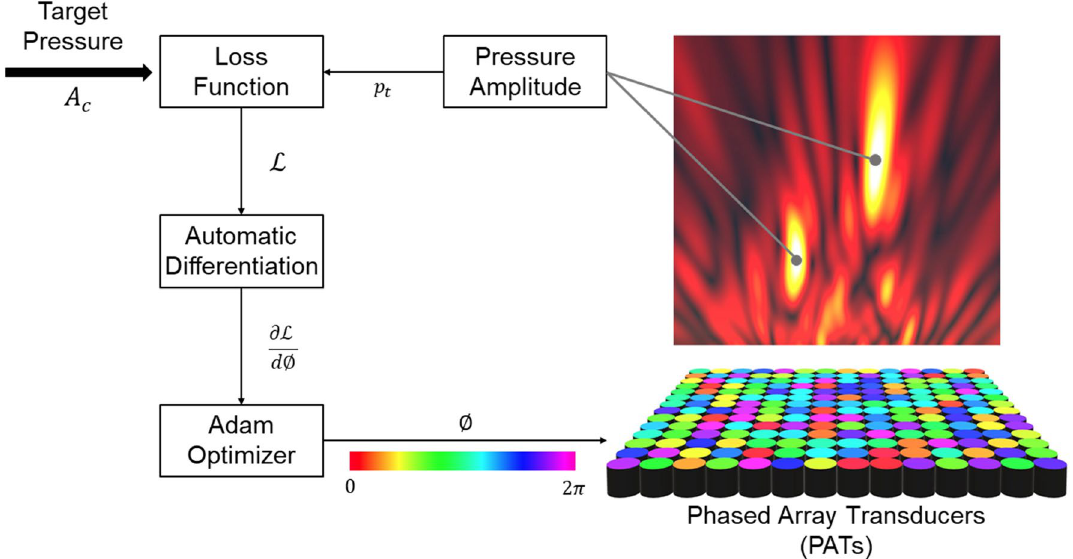
Figure 1. System overview for Diff-PAT. Loss function is evaluated by comparing the target and current acoustic amplitude, and automatic differentiation is used to calculate the derivative of the loss function. Image created using Microsoft Office PowerPoint 2019 (https:// www. micro soft. com/ en- ww/ micro soft- 365/ power point), Unity Version 2019.2.1f1 (https:// unity. com/), and MATLAB 2020a Update 4 (https:// www. mathw orks. com/ downl